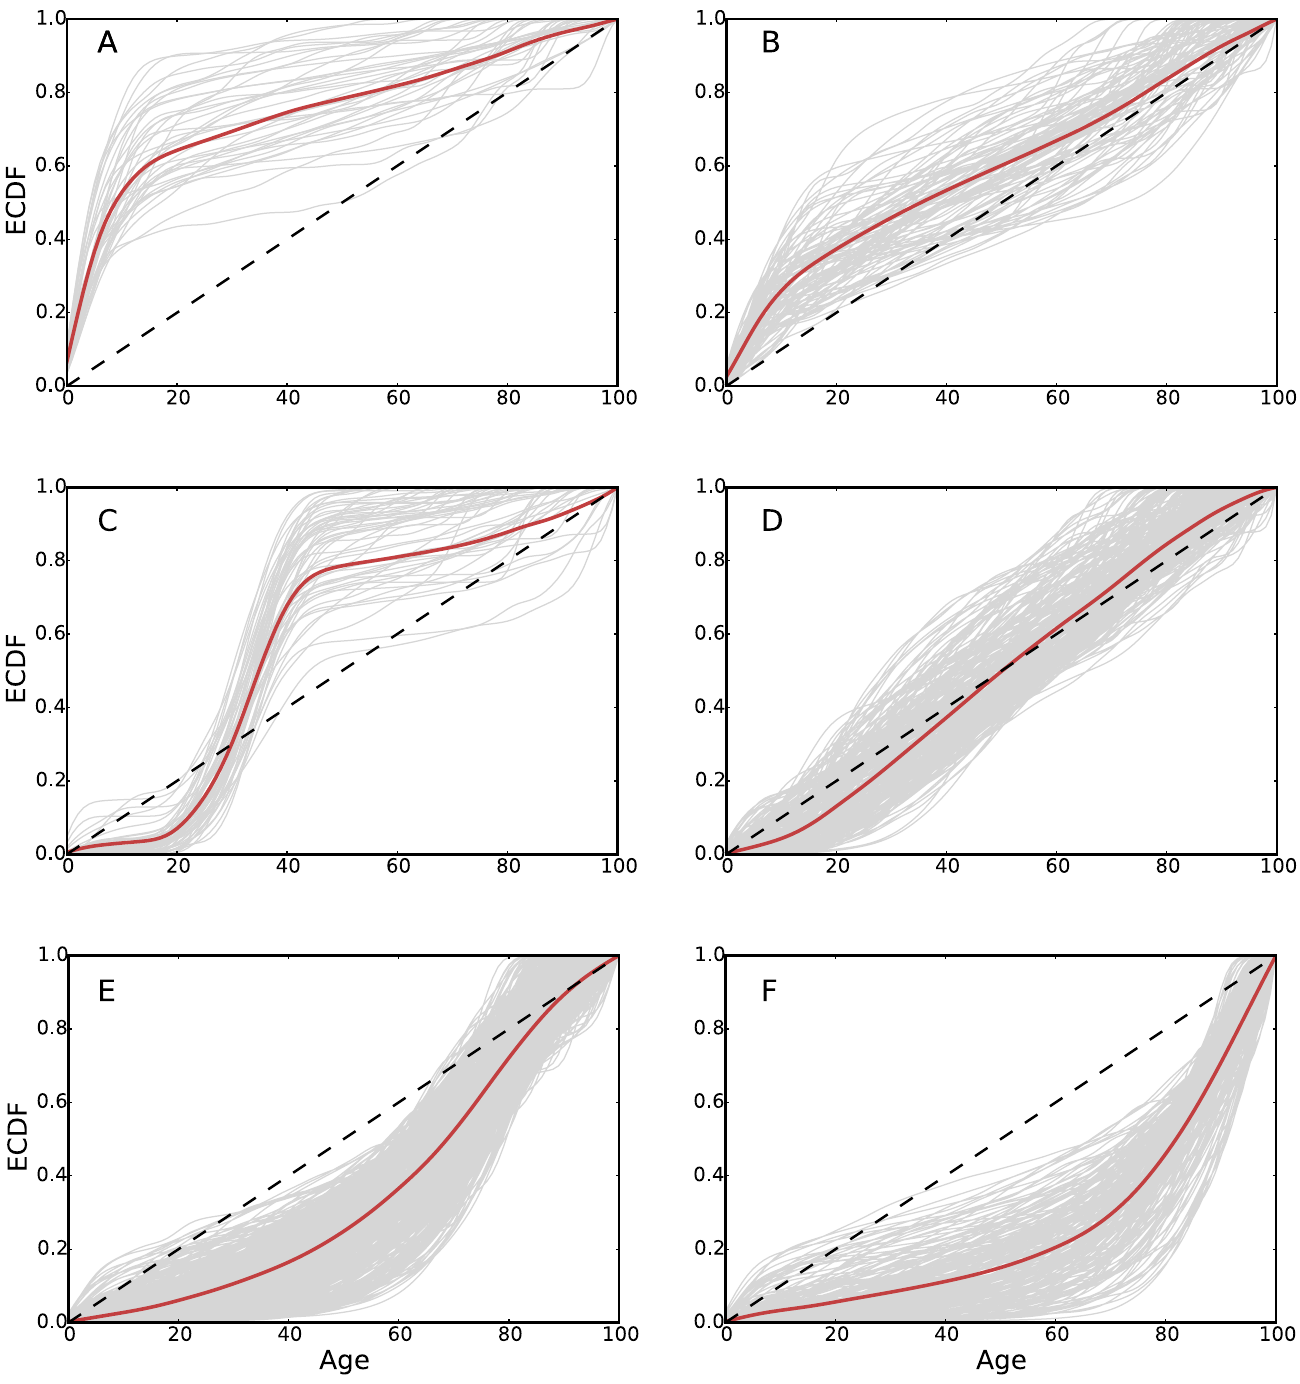
Fig 4. Lines in gray represent cumulative distribution of P ( age | patients 2 c ) and lines in red are the cluster averages for illustration. The clusters of ICD-10 codes given by the HAC are labeled from A to F. Cluster A of ICD-10 codes have more concentration towards infants and children. Cluster B of diseases having a density closer to a uniform but with a tendency to have relatively more concentration in teenage years and early adulthood. Cluster C has the narrowest concentration of age in the thirties. Cluster D groups codes that distribute uniformly in all ages. Cluster E groups codes for ages over 60. Cluster F groups ICD-10 codes in patients over